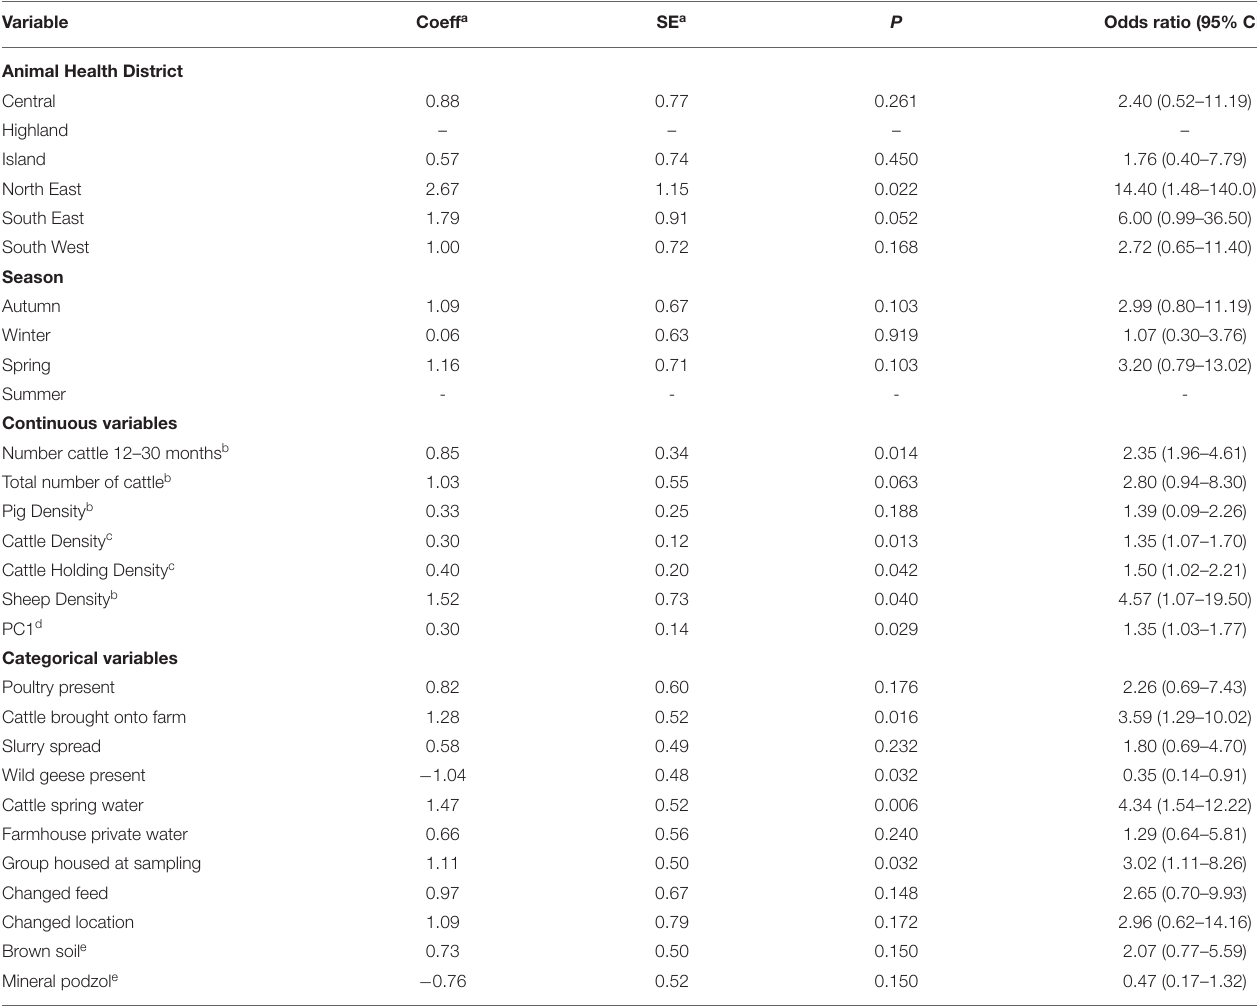
TABLE 1 | Region, season and herd management variable association with herd intI1 PCR status, by a univariable generalized linear mixed model, given as odds ratio with corresponding 95% confidence intervals (CI), for variables where P < 0.25.